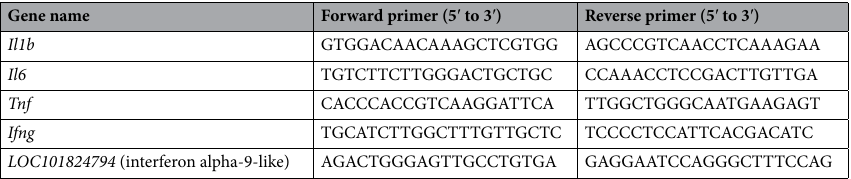
Table 1. Sequences of primers for quantitative PCR detection of cytokines in